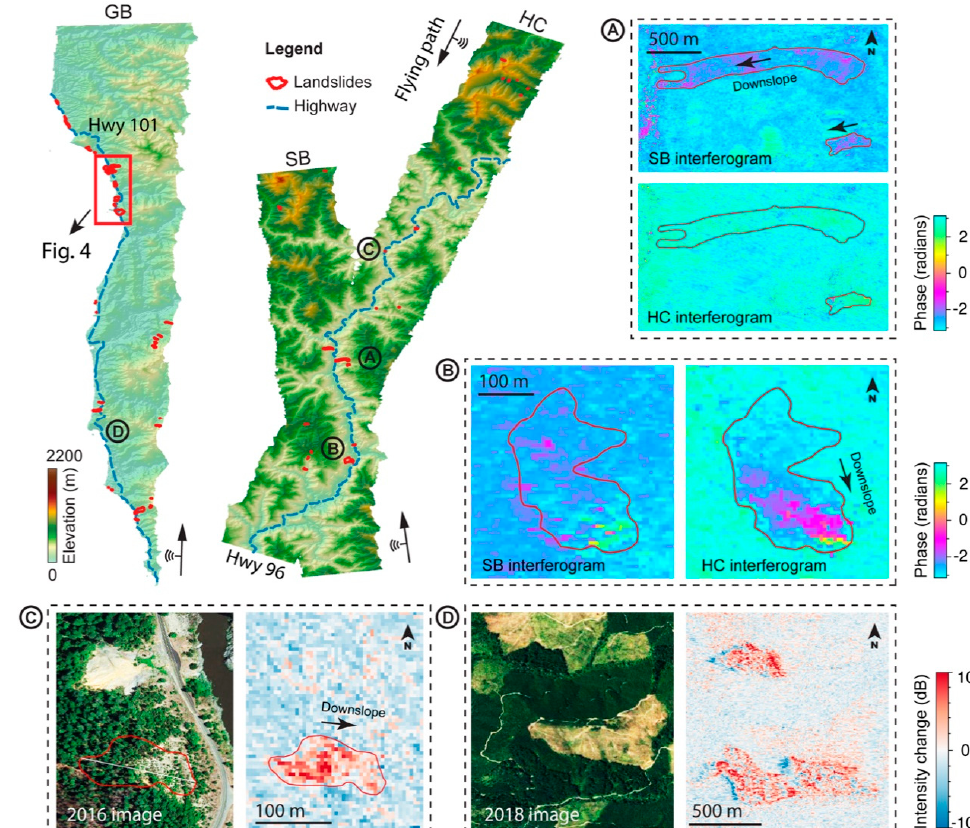
Figure 2. Detected geohazards over the three target regions using P-band InSAR. Red polygons outline the identified landslides from P-band InSAR. SAR interferograms and intensity changes of four selected areas ( A – D ), which are marked on the hillshade maps at the upper-left corner, are depicted in four corresponding close-up figures. ( A , B ) show SAR interferograms of landslides from different radar look angles. ( C , D ) show the SAR intensity changes of a possible landslide runout and clear-cut, respectively. The true color images in ( C , D ) were accessed from Google Earth. Spatial sizes of the identified landslides range from 4.4 × 10 3 to 7.2 × 10 5 m 2 . Among